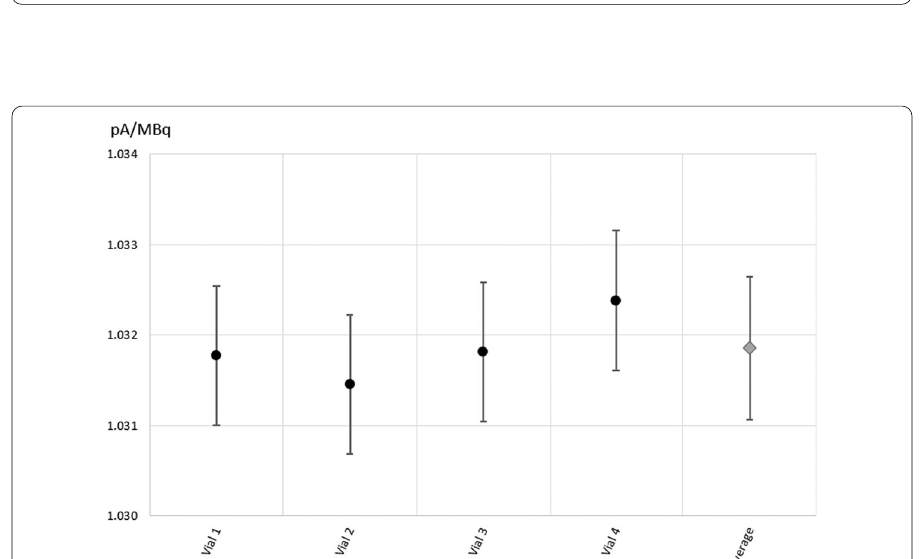
Fig. 12 Normalized current values for the four GMP vials filled with 20 mL 161 TbCl 3